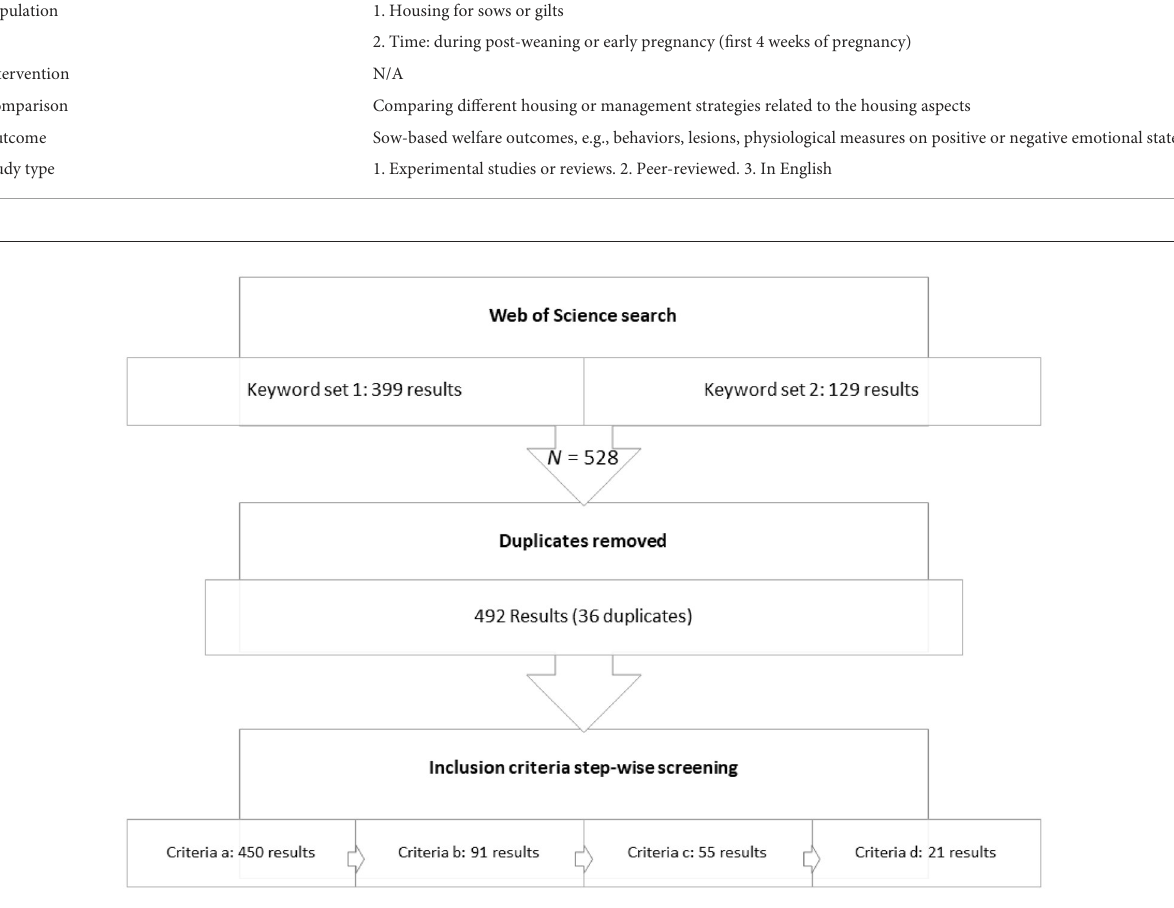
implantation, when external stressors should be avoided (51). Housing during the post-weaning